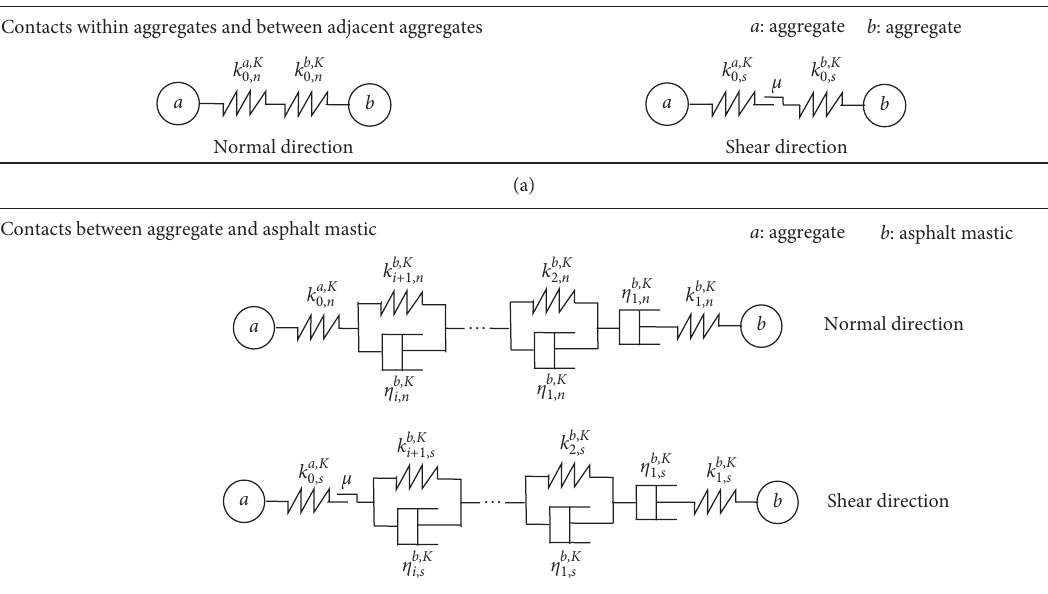
Normal direction Shear direction